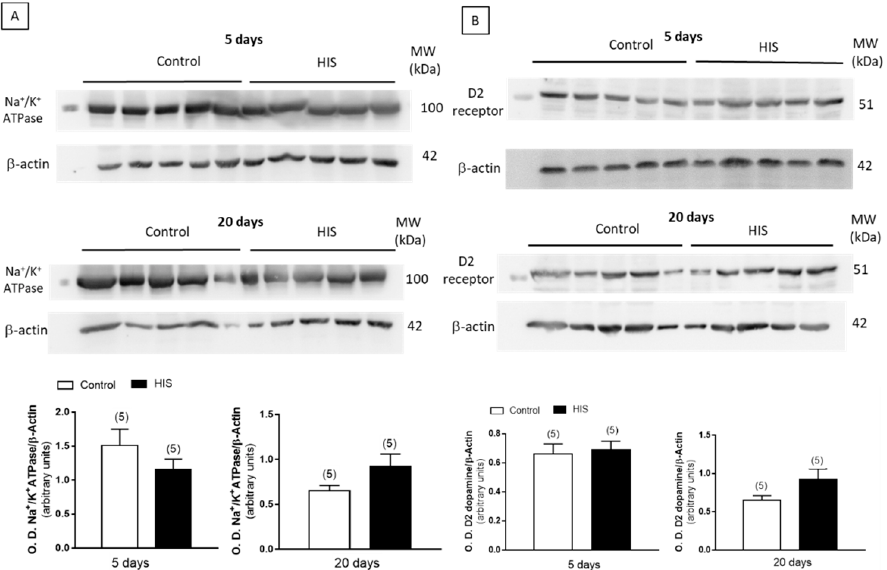
Figure 8. Immunoblotting analysis of alpha subunit of Na + /K + -ATPase ( A ) and dopamine D 2 receptor ( B ) in cortical plasma membranes from rats 5 and 20 days after HIS. Plasma membranes (40 µ g) were subjected to SDS-PAGE, electrophoretically transferred to nitrocellulose and probed with anti-alpha 1 Sodium Potassium ATPase and anti-Dopamine D 2 receptor antibody antisera, as described in Materials and Methods. Data, expressed as arbitrary units, are means ± SEM of experiments performed with five different plasma membrane preparations (Supplementary Material: Figures S1–S8).